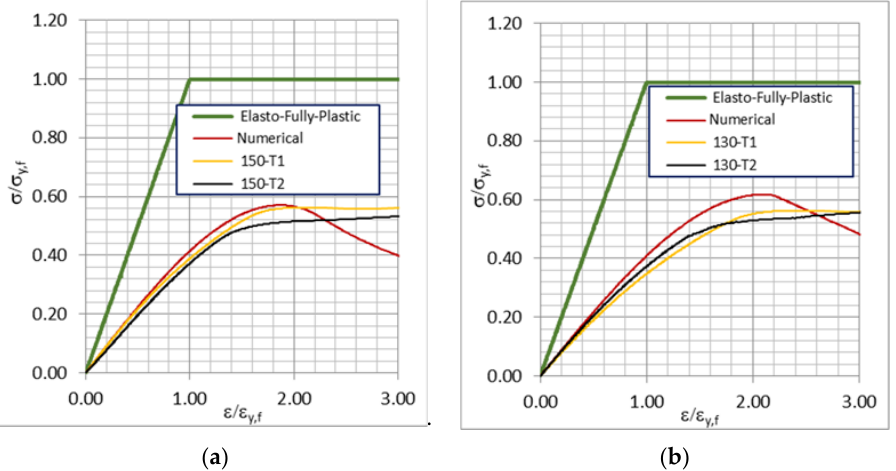
Figure 8. Stress–strain relationships of elastic–fully plastic numerical and experimental results of specimens T1 and T2 for a span of 150 mm ( a ) and 130 mm ( b